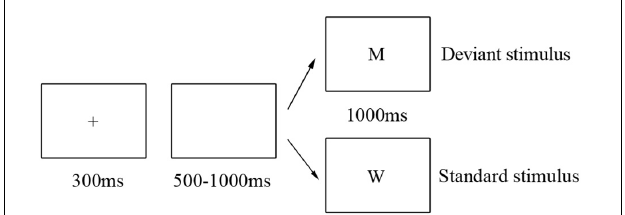
FIGURE 1 | Materials and procedure. Trial progression for the two-choice oddball paradigm. Deviant stimuli (15% probability) were indicated by the letter “M,” and standard trials (85% probability) were indicated by the letter